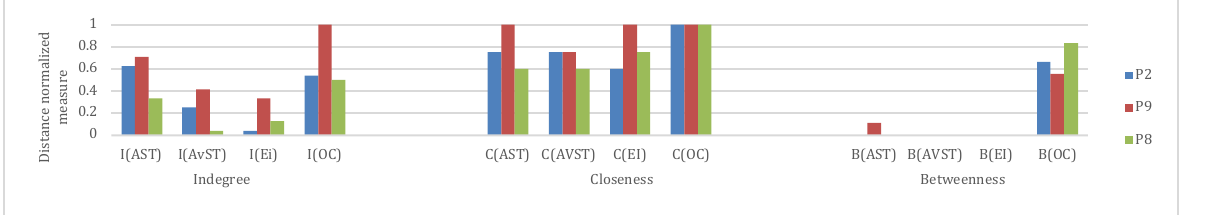
Figure 24a) Distance normalized measure values for AOIs during Take-off flight phase.